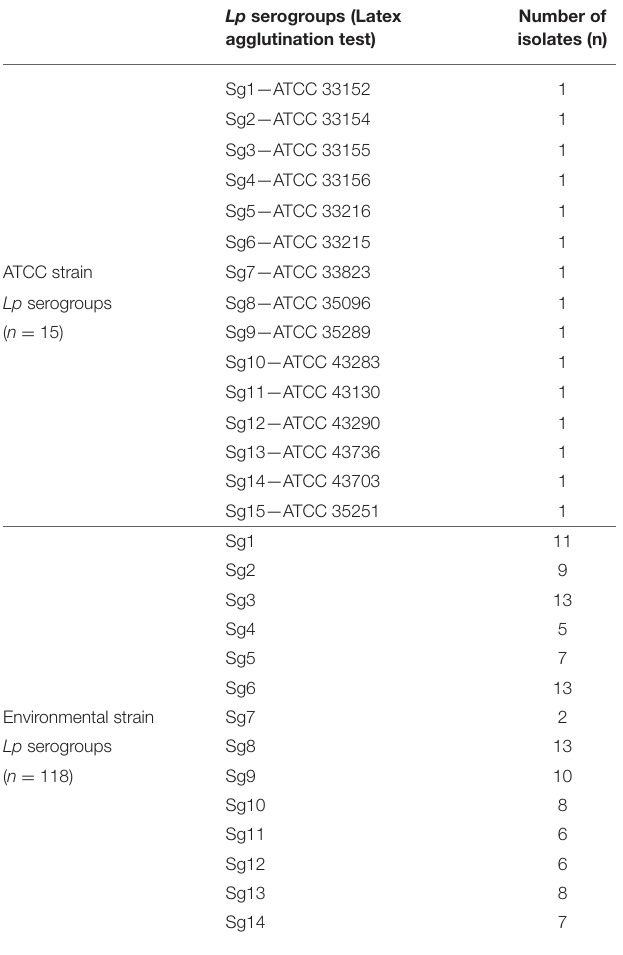
TABLE 1 | The number of environmental and ATCC Lp serogroups isolates included in the study.